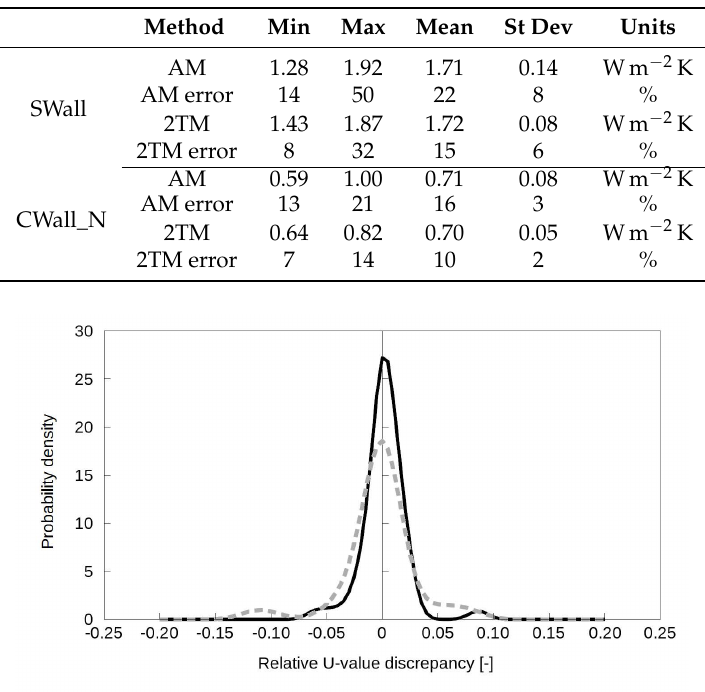
Table 3. Minimum, maximum, mean, and standard deviation of U -value and relative systematic measurement error estimates for the SWall and the CWall_N, using the average and dynamic (2TM model) method and hypothetical monitoring campaigns of different length.